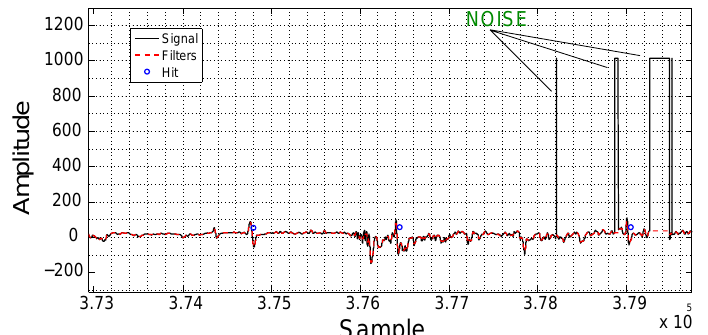
Figure 9. Example of Heaviside noise. The acquired signal can be seen in black and the filtered signal in